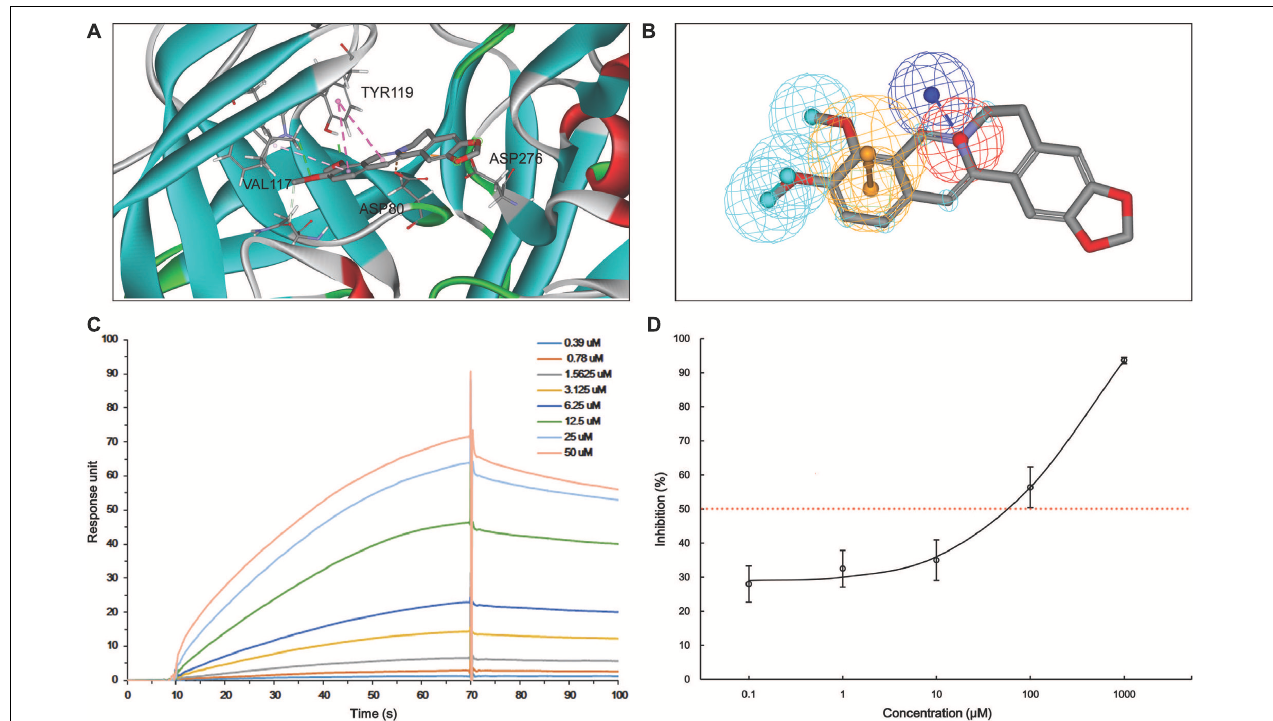
FIGURE 3 | The action of berberine on BACE1. (A) The binding motif of berberine within BACE1. Secondary structural elements are depicted as ribbons (coils, α -helices; arrows, β -sheets). Color-coding is based on the secondary structures ( α -helices, red; β -sheets, skyblue; loops, green). The berberine and key residues are shown as sticks with carbon, oxygen and nitrogen colored gray, red, and blue. Electrostatic interactions are shown as dashed lines with π – π and π -alkyl colored purple and pink, respectively. (B) The pharmacophore model of berberine obtained for BACE1. The colored spheres identify the position and the type of binding features (aromatic rings, orange; hydrophobic portions, cyan; cations, red; anions, blue). (C) The binding of berberine to BACE1. The association and dissociation of berberine with immobilized BACE1 was analyzed using SPR. (D) The inhibition of BACE1 enzymatic activity by berberine in a concentration-dependent manner. The data are represented as the mean ± SD of five replicates.